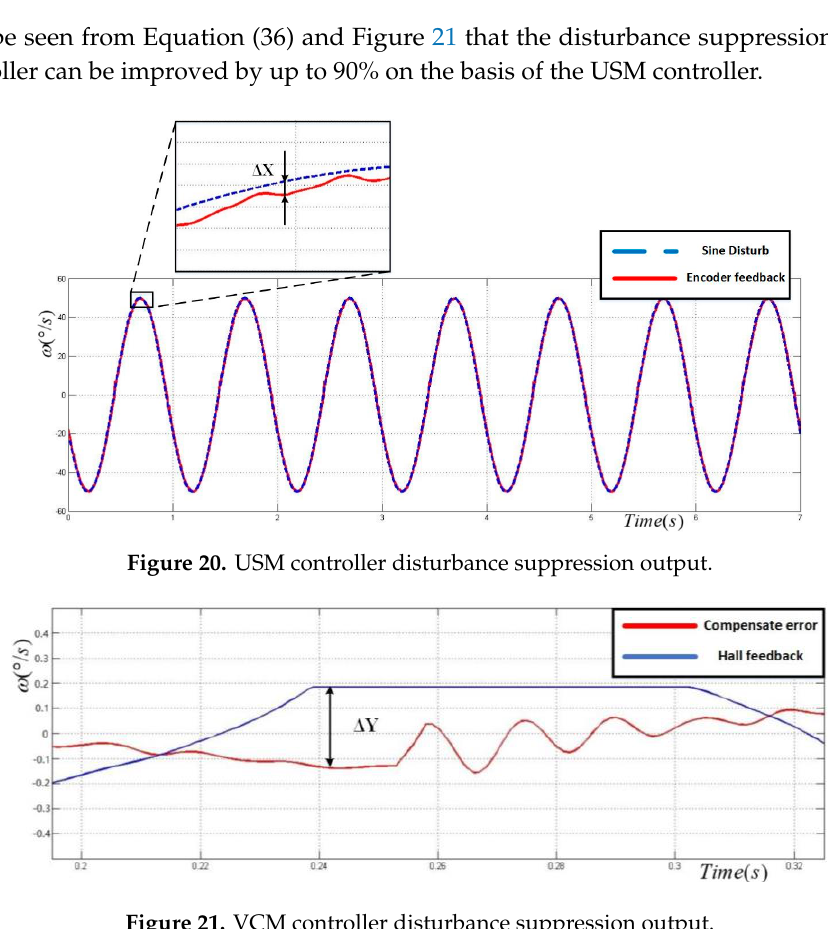
Figure 19. Disturbance suppression output. ( a ) The original curve, ( b ) The enlarged curve.